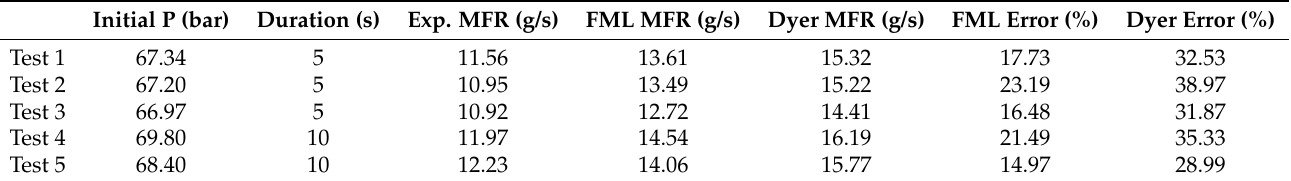
Table 3. Comparison between the average experimental mass flow rate and the one predicted by the FML and Dyer’s model for the second experimental setup.